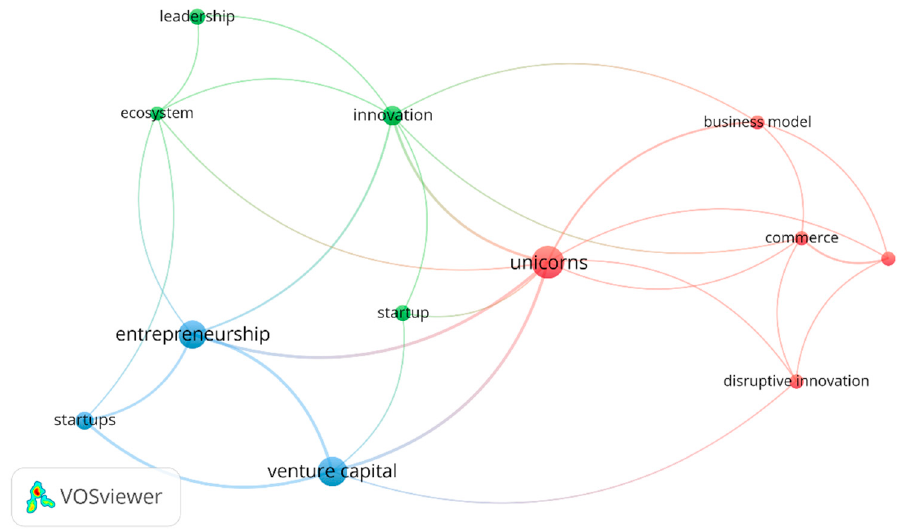
Figure 7. Network visualization (unicorns—SCOPUS). Cluster 1 (Green), Cluster 2 (Red), Cluster 3 (Blue).